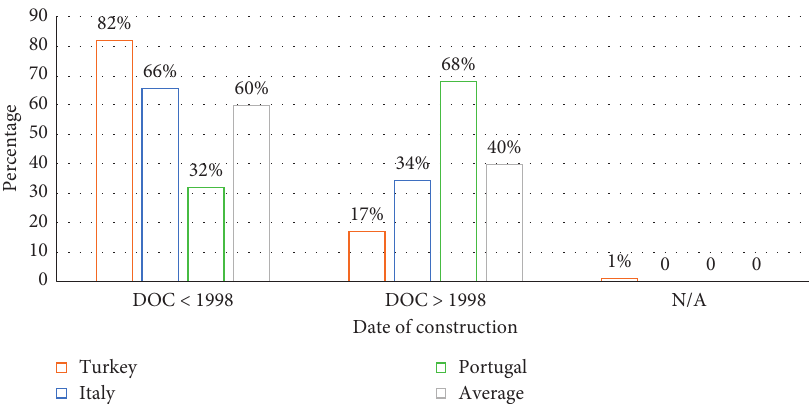
Figure 27: Comparison of date of construction (DOC) of precast RC buildings in Portugal and